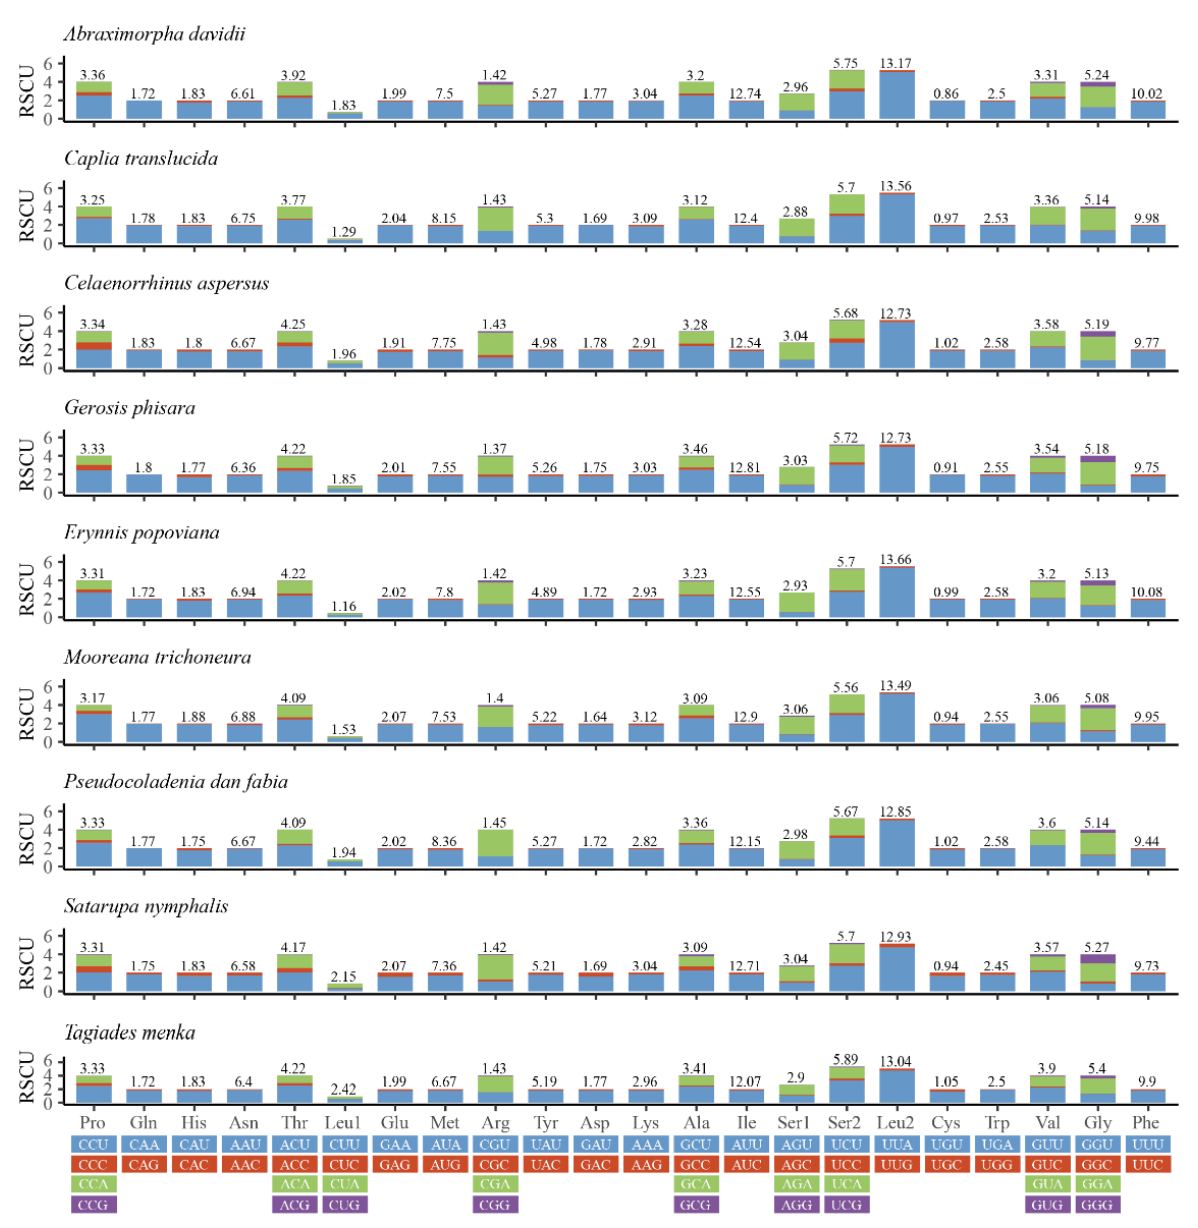
Figure 2. Relative synonymous codon usage (RSCU) in the mitogenomes of nine species.